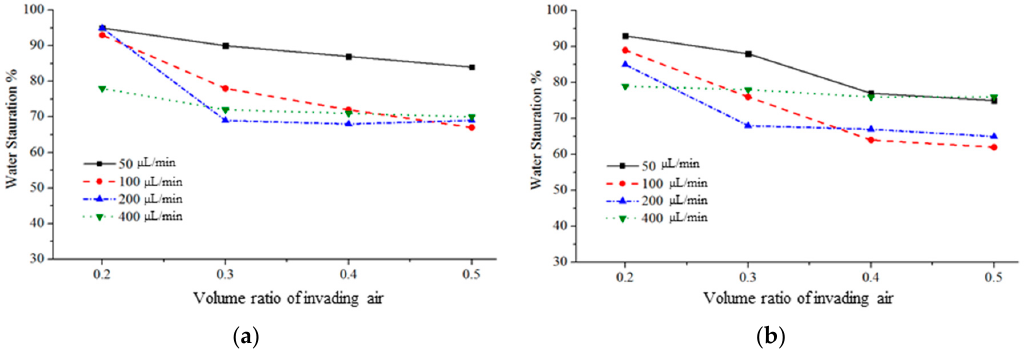
Figure 9. Water saturation versus the volume ratio of invading air in the models with ( a ) different air injection rates and ( b ) different water extraction rates.